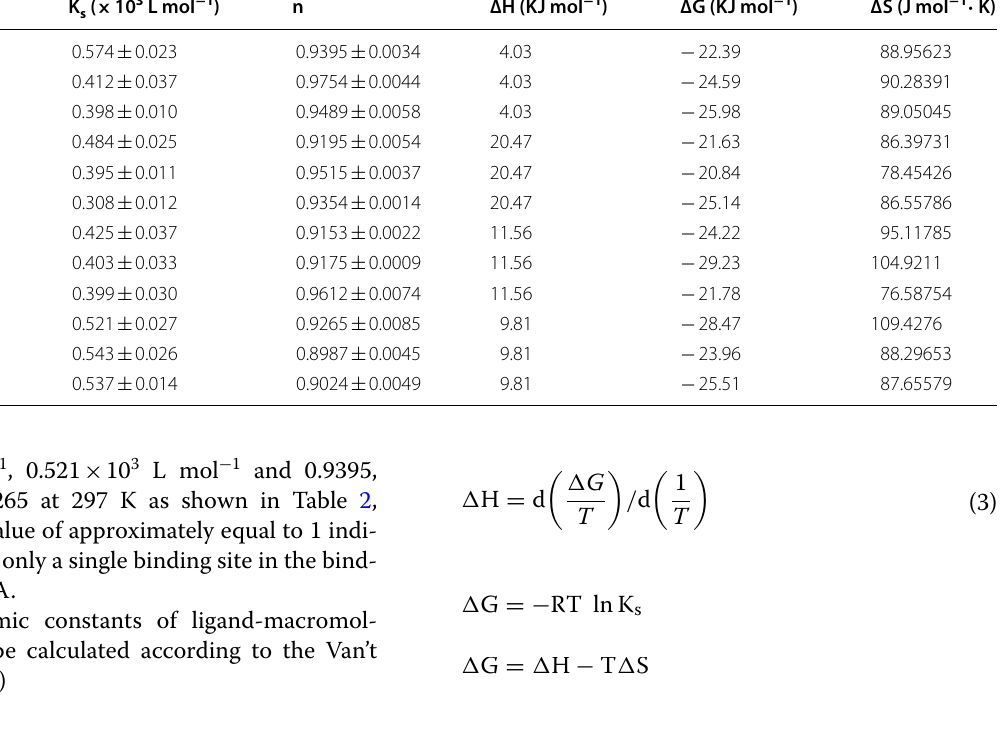
Fig. 3 The double logarithm regression curve of log [(F 0 Cyanidin-3-i-glucoside ( c ) and Cyanidin-3- O -Xyloside ( d ) at 297, 317 and 337 K